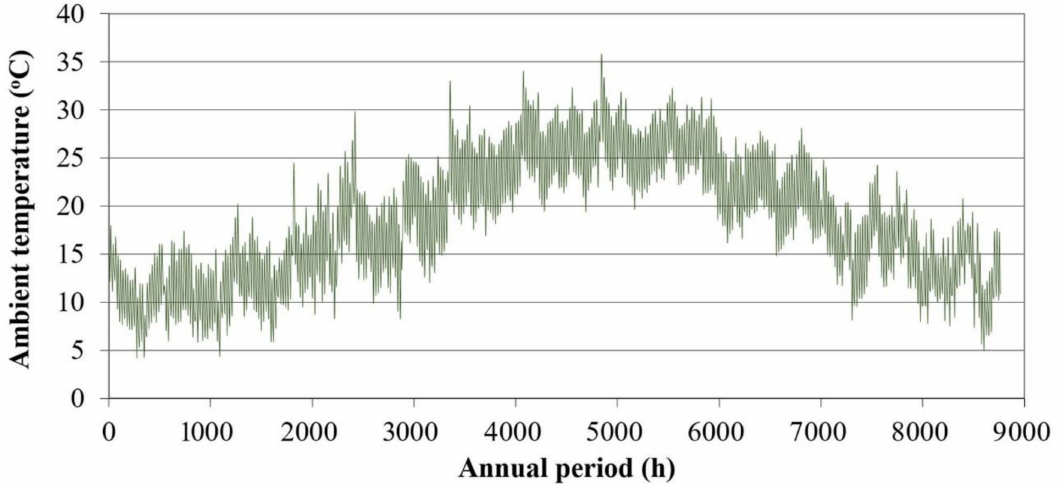
Figure 9. Annual ambient temperature fluctuation at the town of